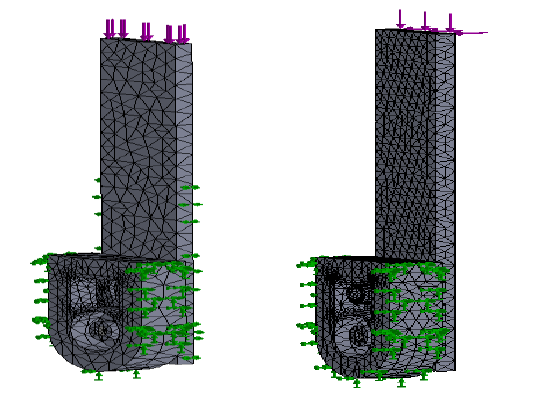
Figure 2: Load and fixture conditions on meshed QRM with two loading types: shearing caused by either walking or running (Left); bending caused by landing on uneven ground, representing downhill walking load (Right).